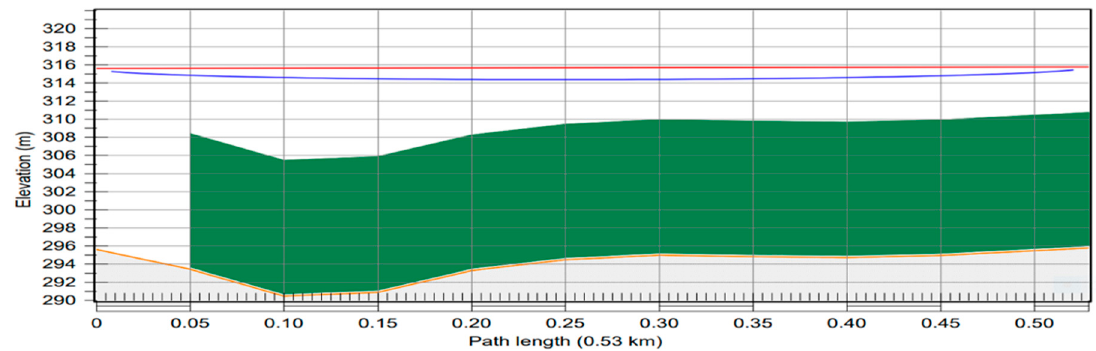
Figure 2. Microwave link in line of sight (Aviat Network, Inc. (July 2017)).